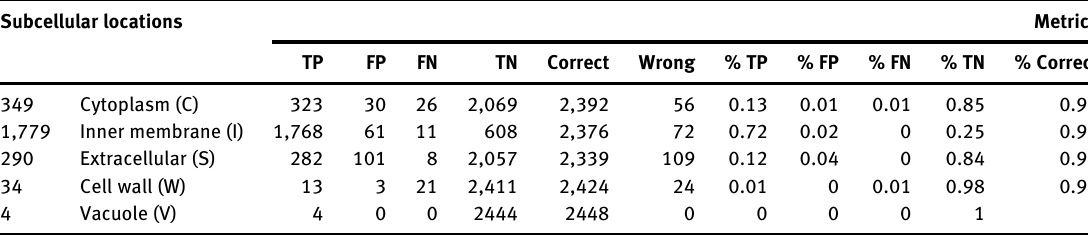
Table  : Performance evaluation by  -fold cross-validation tests on Gram-positive bacteria proteins using a consensus of both GO terms and PSSM pro fi les predictions. The multi-label confusion matrix re fl ects well the predictions performance for each location